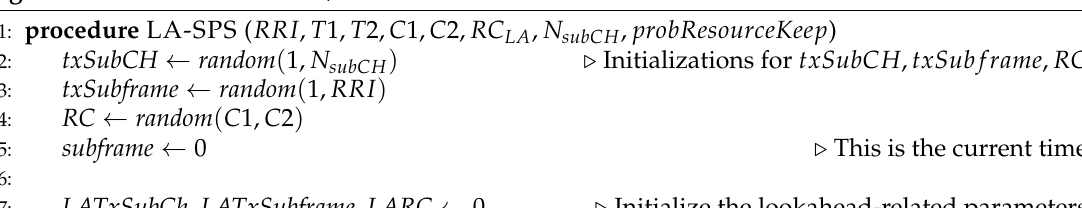
Algorithm 2 Reselection in